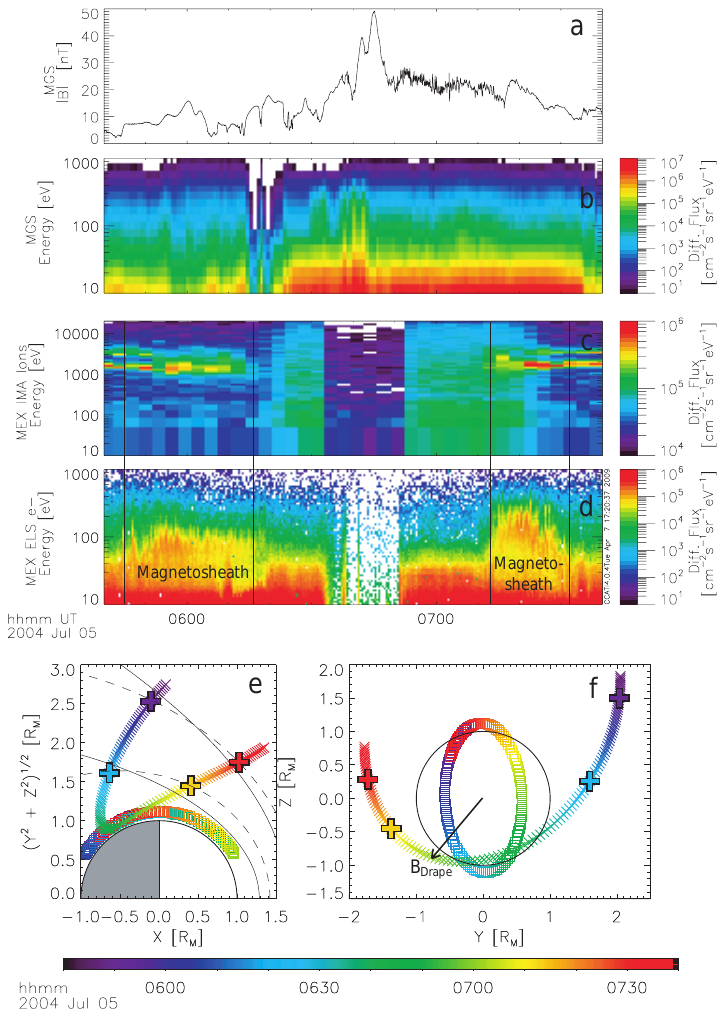
Fig. 5. As for Fig. 3 except for Case